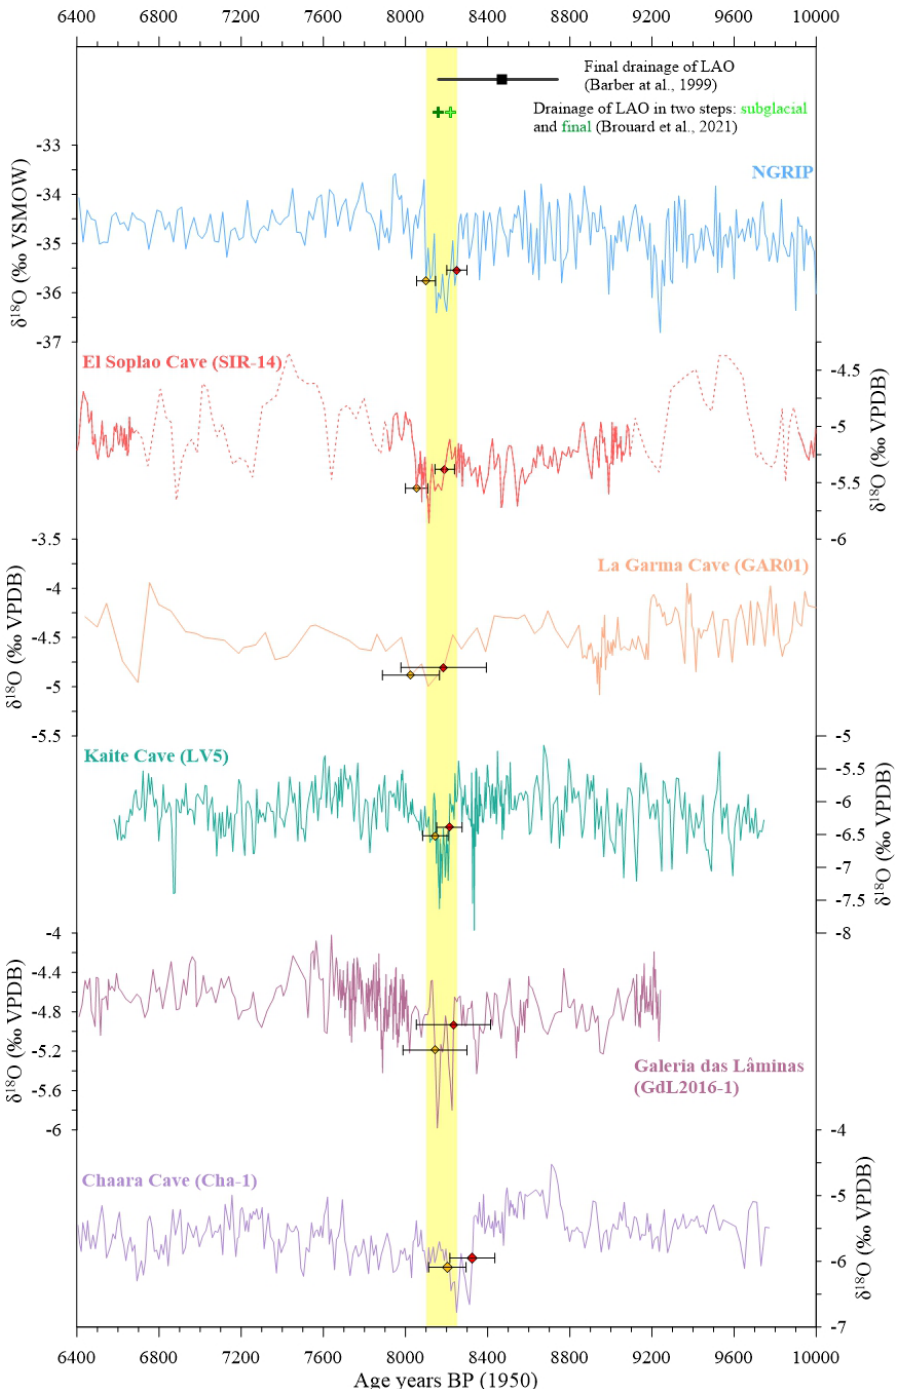
Figure 6. Comparison of δ 18 O records across the 8.2ka event. From top: timing of the drainage of lakes Agassiz and Ojibway (LAO) (Barber et al., 1999; Brouard et al., 2021); NGRIP ice core record (North Grip Ice Core Project Members, 2004); speleothem records of SIR-14 (this study), GARO1 (La Garma Cave; Baldini et al., 2019), LV5 (Kaite Cave; Domínguez-Villar et al., 2009), GdL2016-1 (Galeria das Lâminas; Benson et al., 2021) and Cha-1 (Chaara Cave; Ait Brahim et al., 2019). The intervals of slow growth in SIR-14 (9.9–9.1 and 7.9–6.7ka) are shown as dotted lines, as they are representative of drip-specific effects and not regional climate variability. The duration of the event from the NGRIP record is shown by yellow shading. The onset (red) and end (yellow) of the event are indicated by coloured markers (see text for explanation for determining the onset and end of the